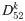
Simulation of particle dispersal with a PLD of 2 months and release on March 1st, 2000.(a) Sample trajectories of Lagrangian particles released from each of the NLIs; filled circles indicate positions and areal extents of the islands, while dashed circles mark their retention zones. (b) Analysis of sample trajectories for Lagrangian particles released from Palmyra Atoll (2, sky blue) and Christmas Island (5, burgundy); first, the minimum distance from each of the NLIs is computed for all trajectories, then ensemble statistics are evaluated. (c) Frequency distribution (50 km bins) of the minimum distances to Palmyra Atoll of the trajectories starting at Christmas Island (D52k, burgundy), and viceversa (D25k, sky blue; inset shows the latter distribution at a finer spatial grain); solid, dashed, dotted and dash-dotted lines mark respectively the positions of the average, median, 10th and 25th percentiles of the frequency distributions (for D52k: 157, 110, 13, 43 km; for D25k: 618, 619, 613, 615 km). (d) Histogram visualization of the between-island connectivity matrix; bars represent the fraction of particles released at source island i (horizontal axis) that cross the retention zone of island j (β = 10 kilometers, island numbers and colors as in panel a).